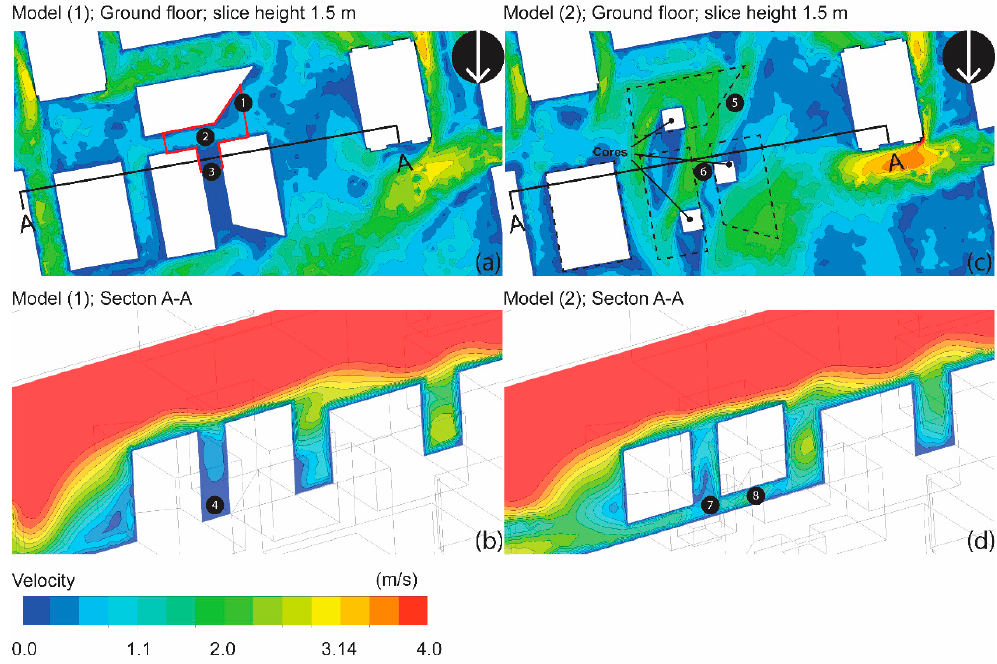
Figure 4. ( a , b ) Impermeable ground floor; ( c , d ) Permeable and openable ground floor.